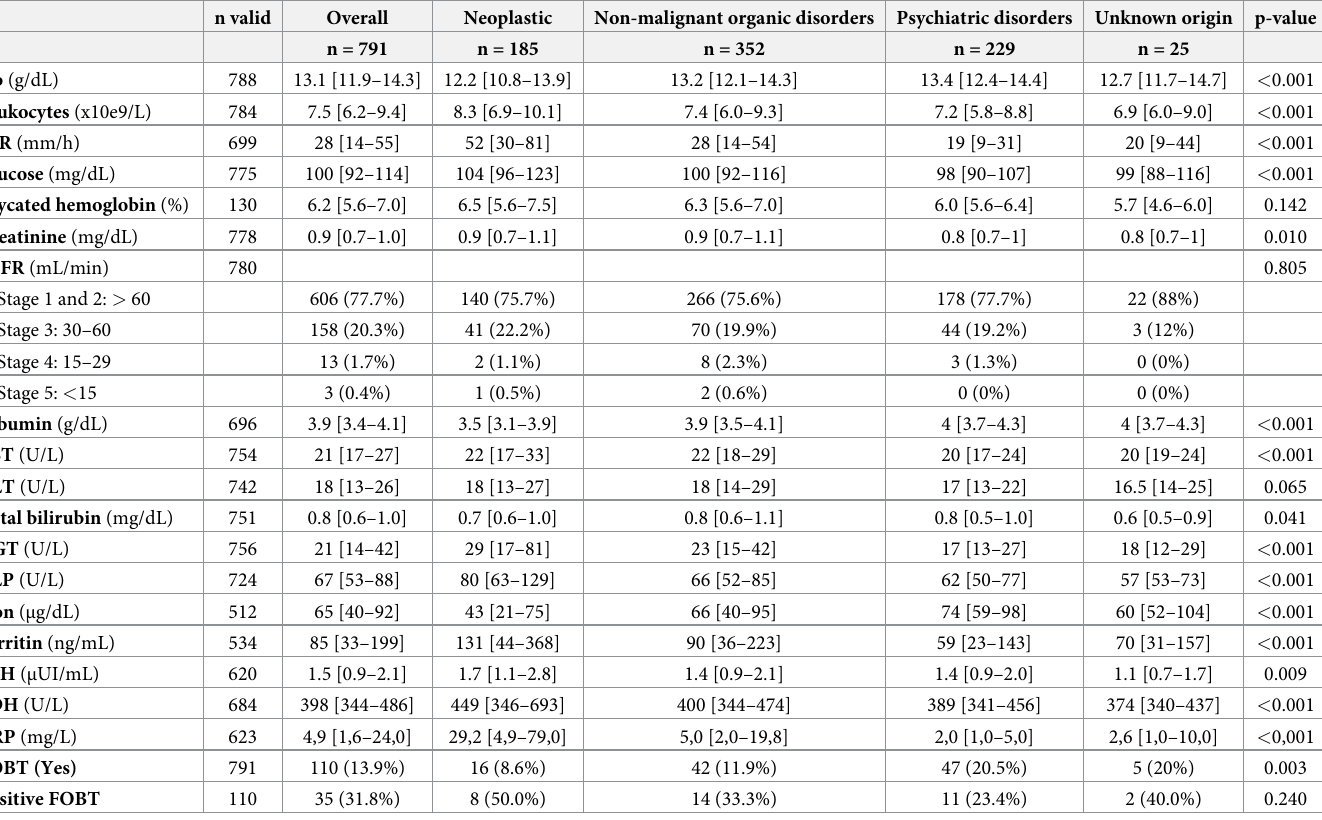
Table 2. Blood and stool analysis parameters of patients with IWL, overall and according to